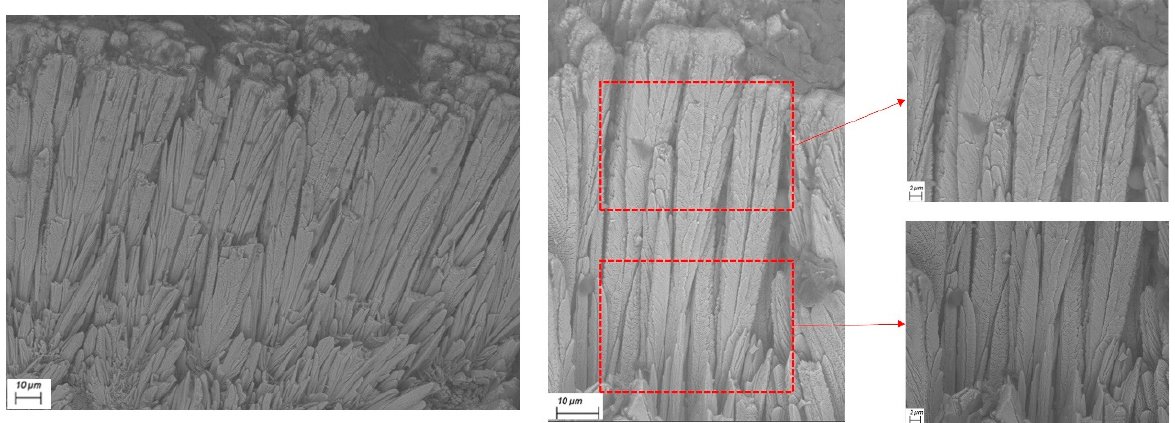
Figure 1. Scanning electron microscopy (SEM) micrograph of the electron beam physical vapor deposition (EB-PVD) coat- ings.